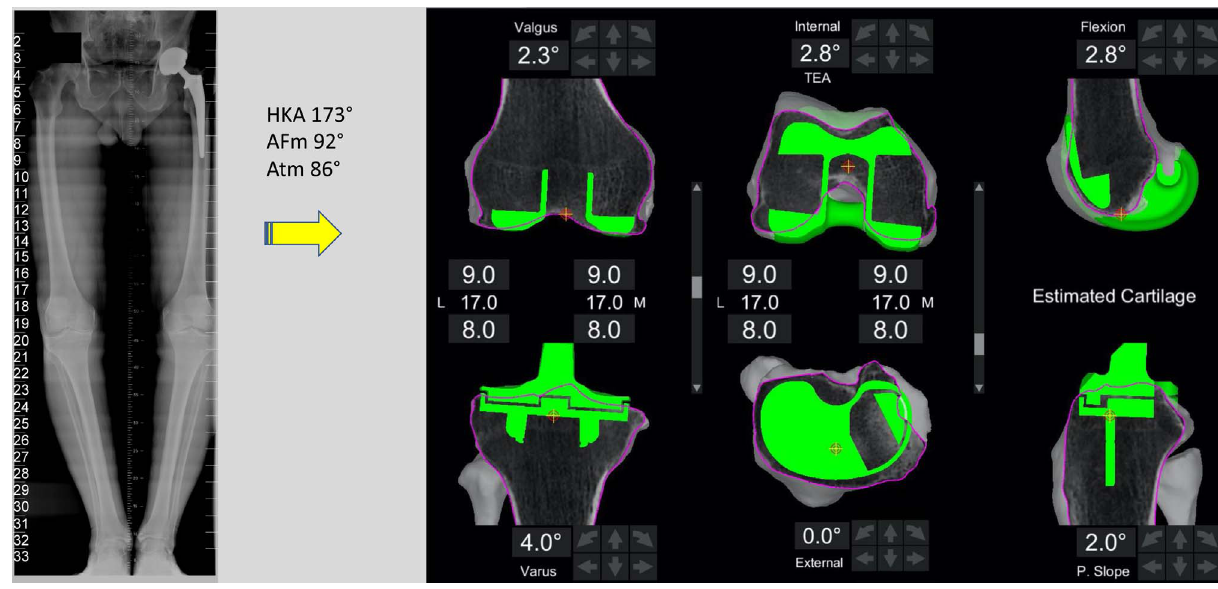
Figure 3. Typical plan for a varus morphotype knee.